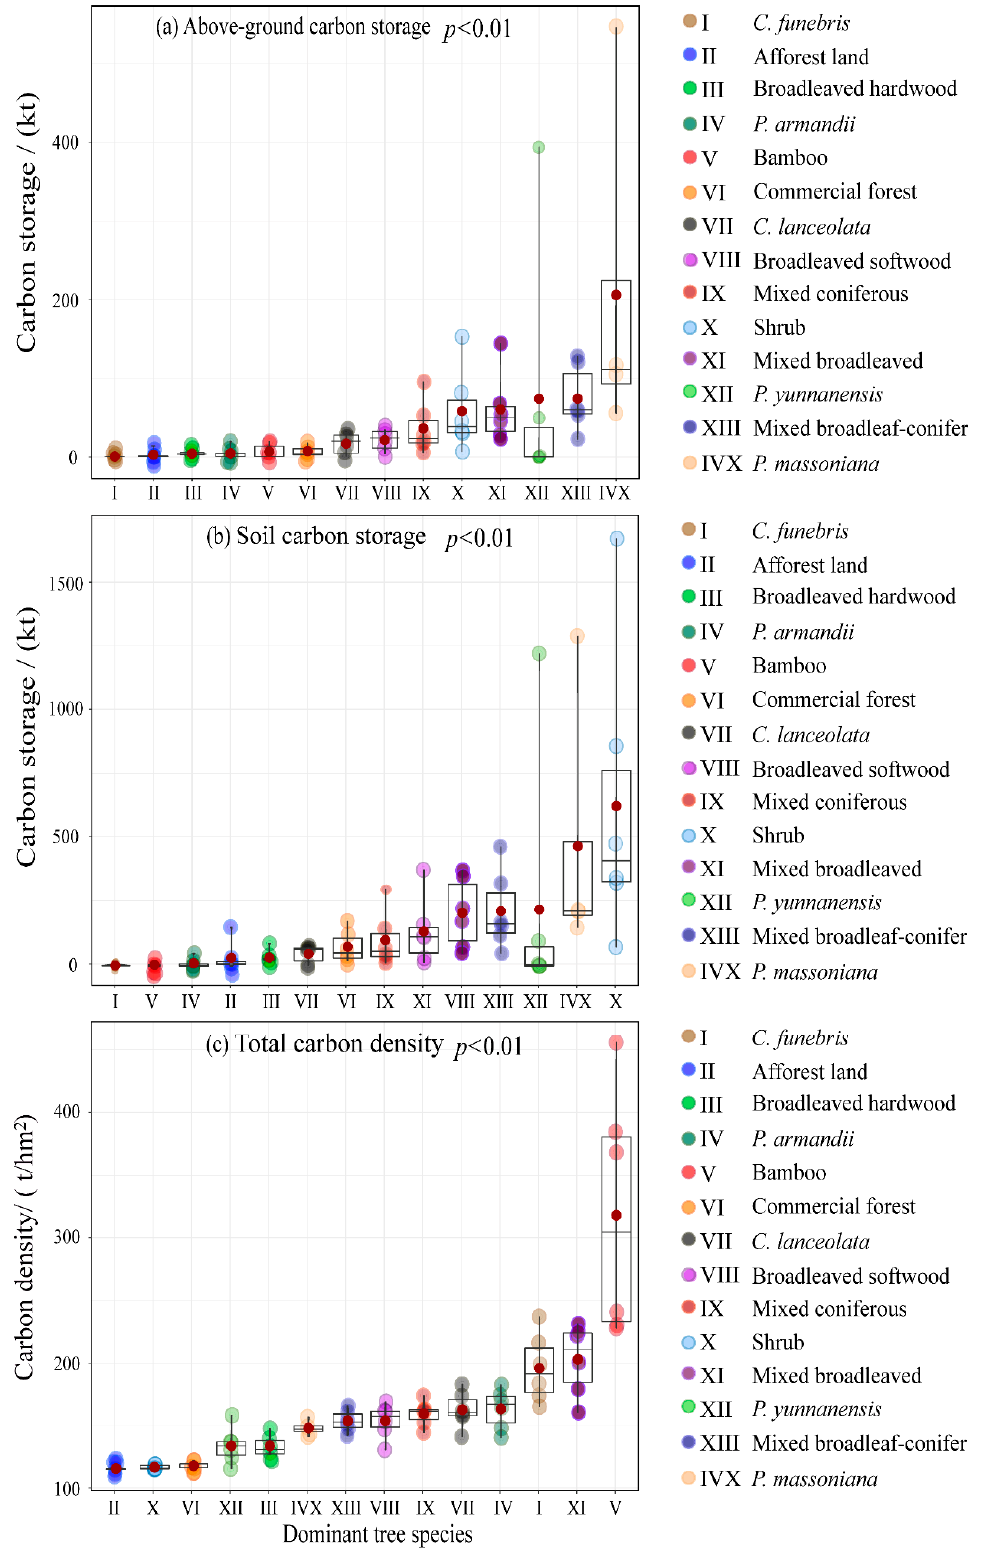
Figure 2. The carbon storages of above-ground biomass in different forest types ( a ); the carbon storages of soil in different forest types ( b ); the total carbon densities in different forest types ( c ).